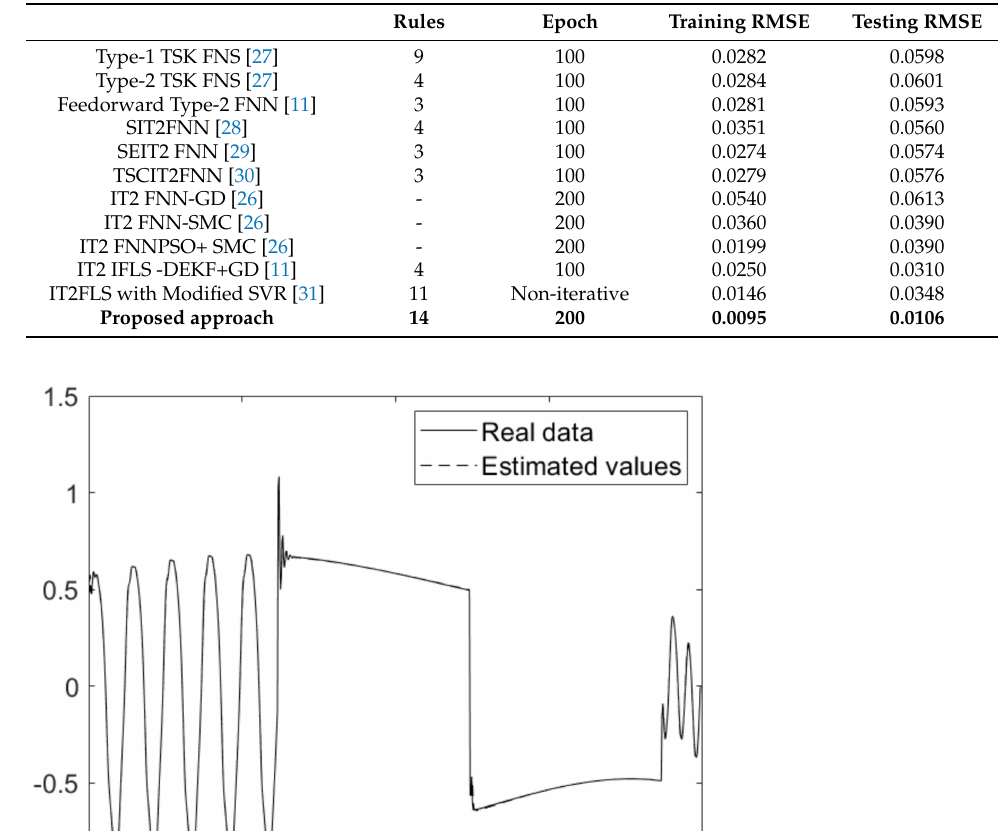
Table 1. Performance of the proposed approach as well as several existing methods in the literature on time-varying system identification. Bold faced results indicate the best results.